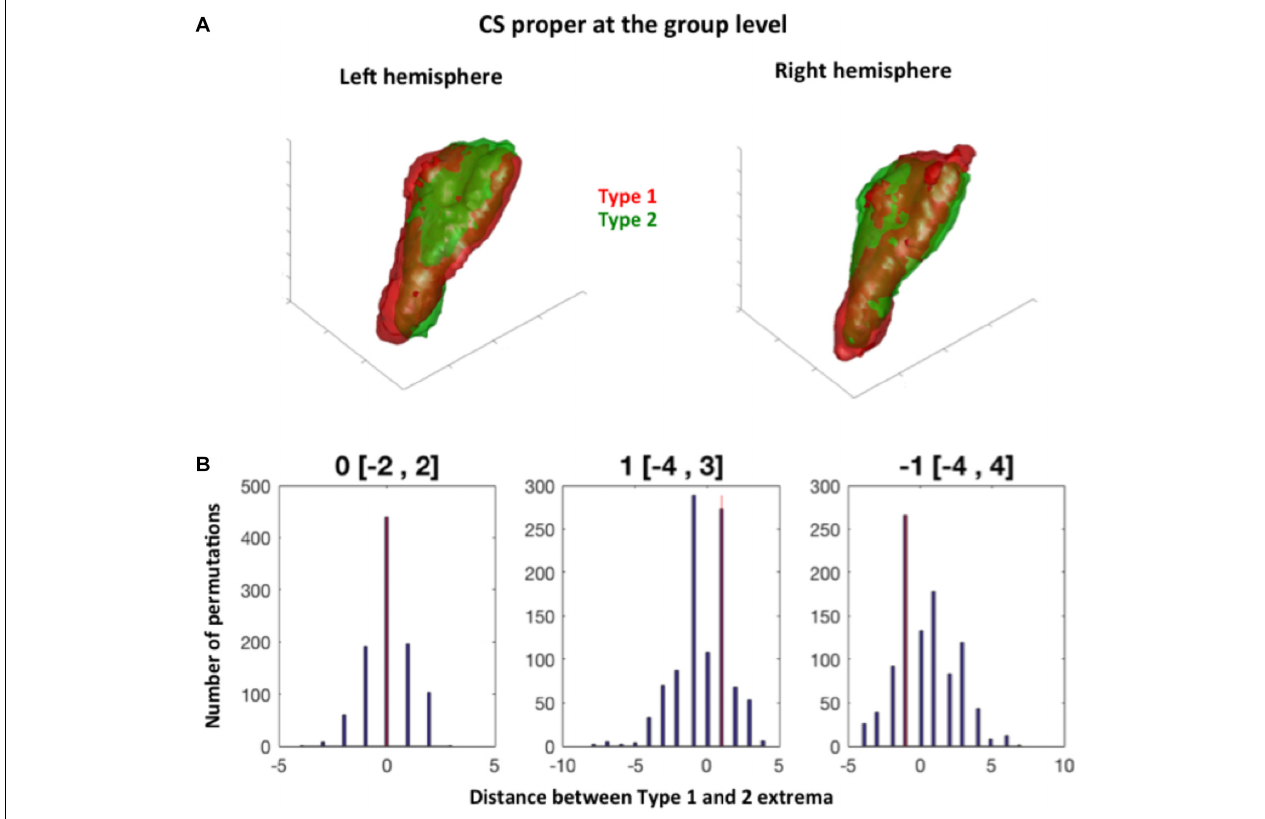
FIGURE 3 | Permutation test procedure. (A) Two blobs are defined at the group level by merging the sulci of Type 1 and Type 2 subjects for a given sulcus (here illustrated with the collateral sulcus proper for both hemispheres). Here, the group-level Type 1 collateral sulcus proper is in red, and the group level Type 2 collateral sulcus in green. A bounding box illustrates the coordinates of these group sulci. (B) The extrema coordinates on the x, y, and z axis between the observed group sulci (shown in A ) and 1000 group sulci generated randomly are